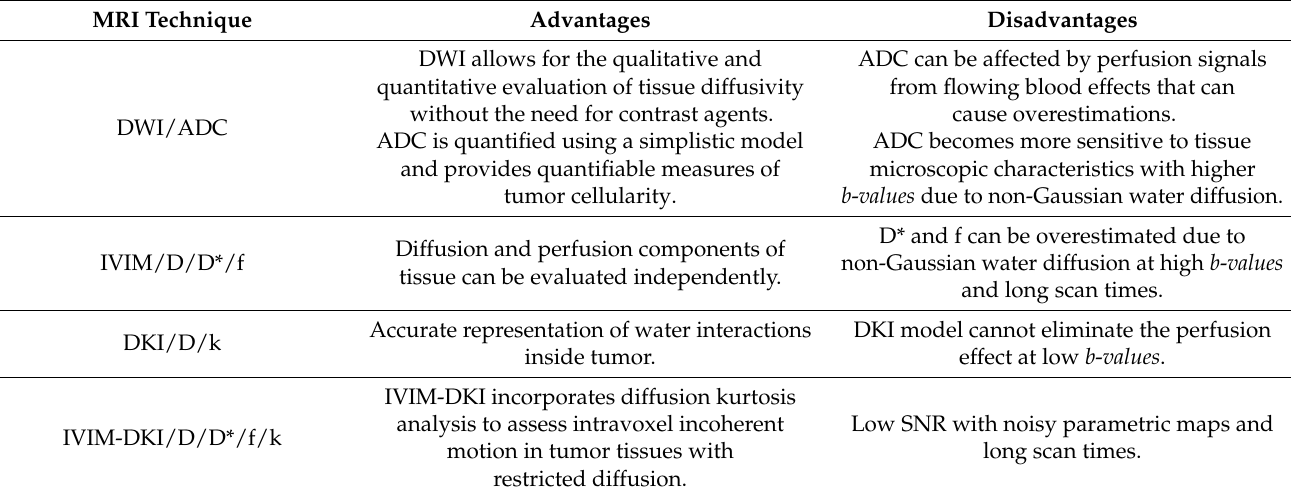
Table 1. Advantages and disadvantages of existing